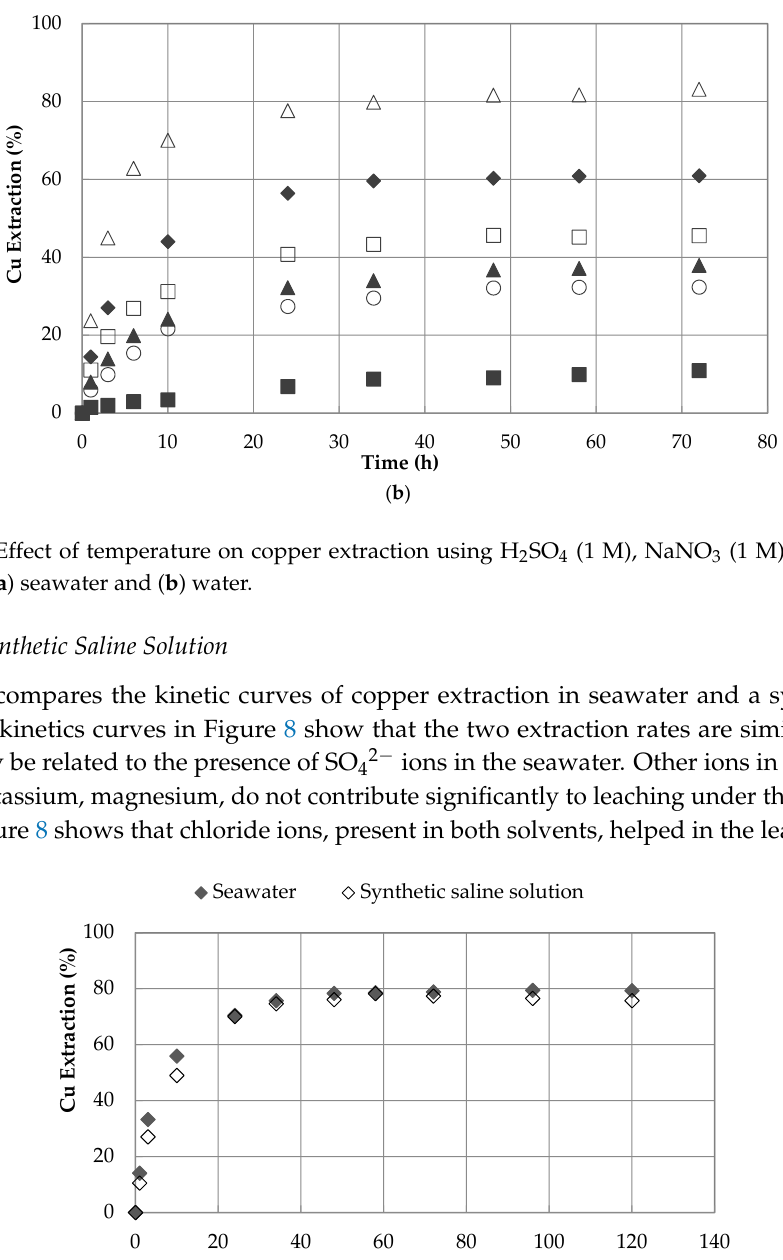
( b ) Figure 9. Optical microscope images of solid residue after leaching from ( a ) seawater, and ( b ) water system. The formation of elemental sulfur as a product of chalcopyrite leaching in both seawater and water-based media was confirmed by SEM-EDS analysis (red region, Figure 10).